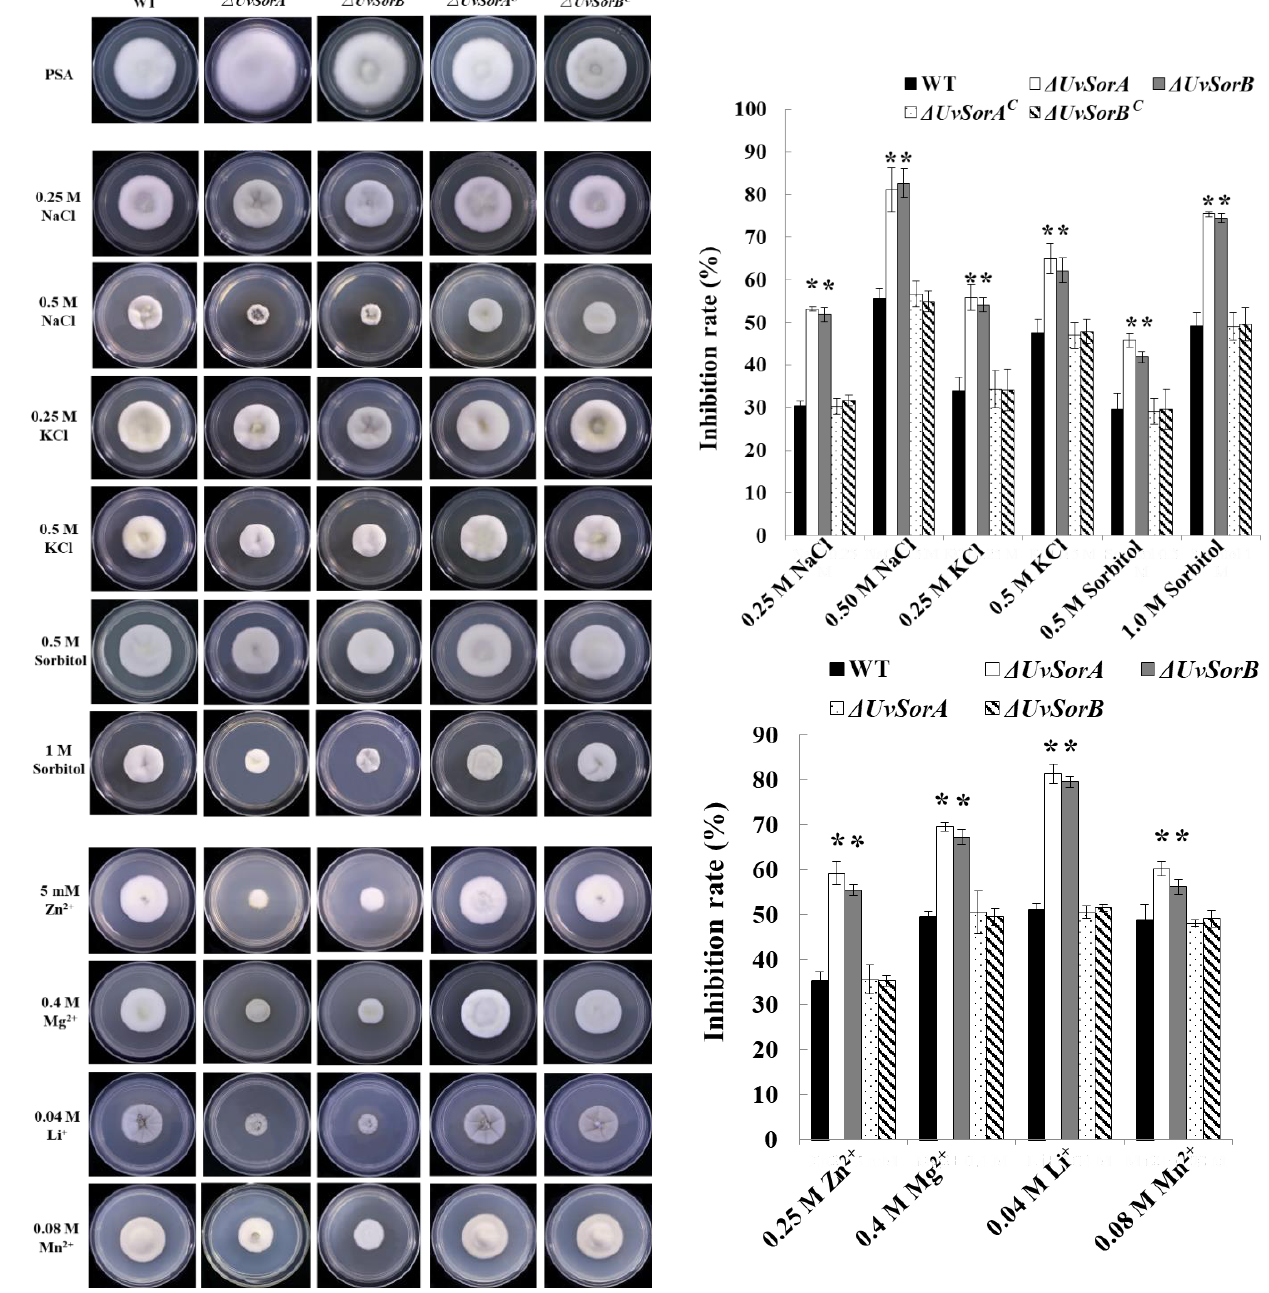
Figure 9. UvSorA and UvSorB contributed to the tolerance to hyperosmotic and metal cation stresses. The colony growth of mutants under hyperosmotic and metal cations stresses grown at 28 °C for 18 days (left panel); Statistical analysis of mycelial growth inhibition rate under hyperosmotic (upper right panel) and metal cations stresses (lower right panel). Measurements of growth inhibition rate of each treated strain are relative to that of each untreated control. Three independent biological experiments were performed with three replicates each time. Error bars represent the standard deviation, and the asterisk (*) represents a significant difference at p < 0.05, ** p < 0.01).